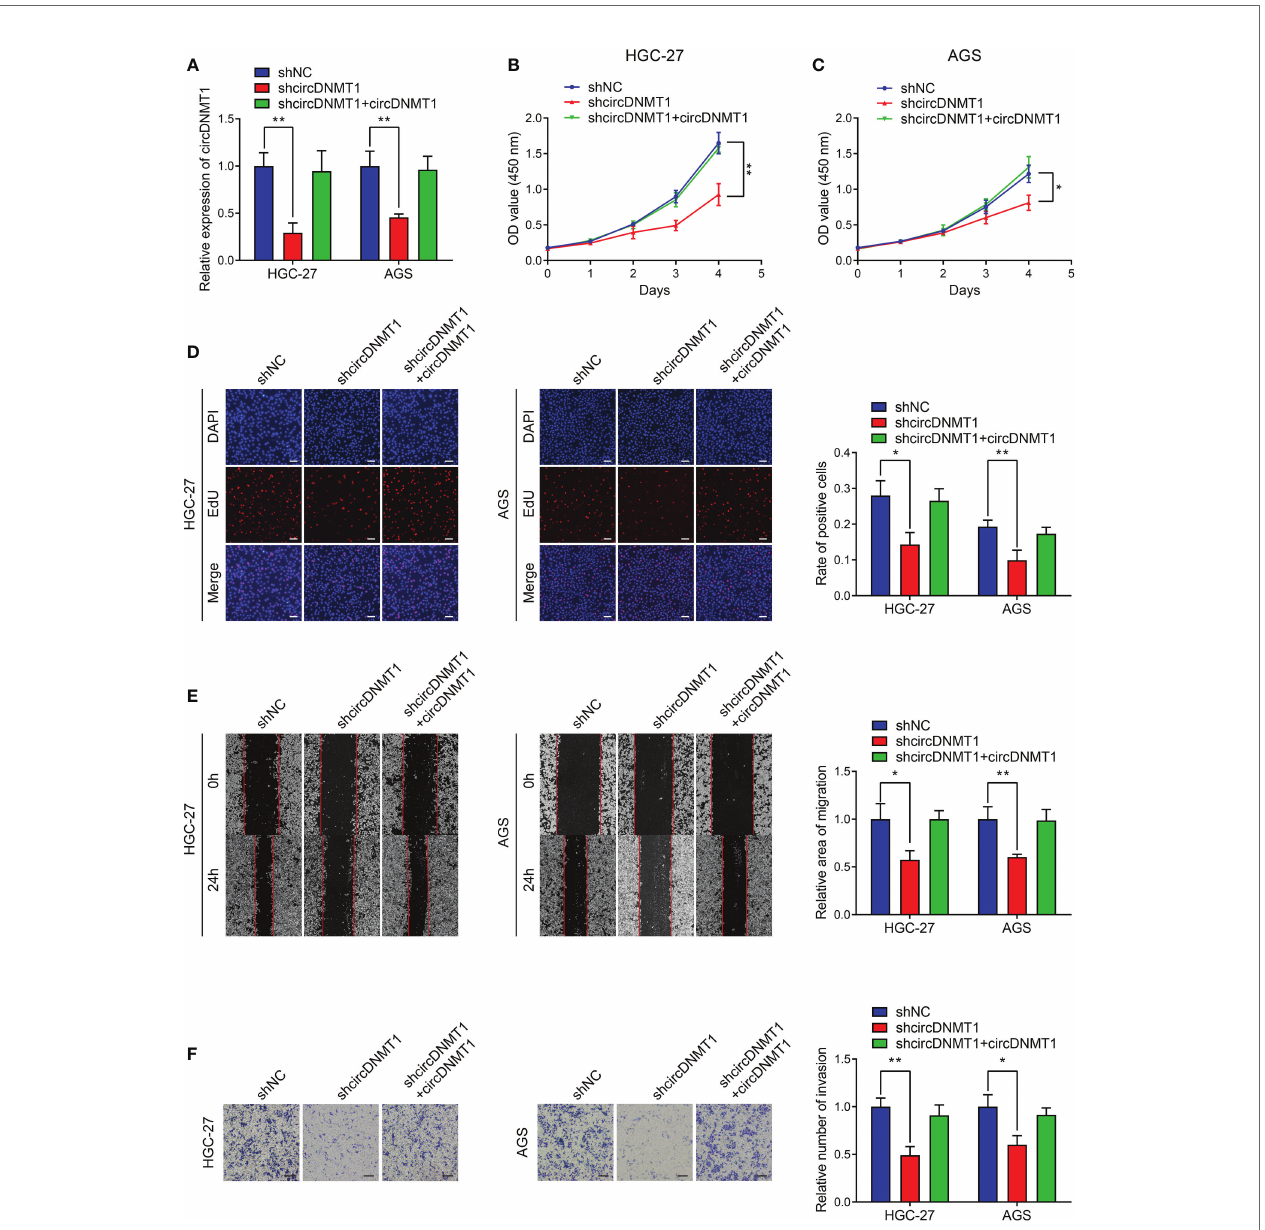
FIGURE 2 | circDNMT1 knockdown inhibits proliferation, migration and invasion of GC cells. (A) The qRT-PCR analysis to show circDNMT1 expression in HGC-27 and AGS cells stably carrying lentivirus with NC shRNA or circDNMT1 shRNA and additionally transfected with vector or circDNMT1 overexpression plasmids. (B, C) The CCK-8 assay to show proliferation of cells as in (A) . (D) The EdU assay to show proliferation of cells as in (A) . Scale bar: 100 m m. The histogram is displayed on the right. (E) The wound healing assay to show migration of cells as in (A) . The histogram is displayed on the right. (F) The transwell assay to show invasion of cells as in (A) . The histogram is displayed on the right. Scale bar: 100 m m. Data were presented as means ± SD. *P < 0.05, **P <